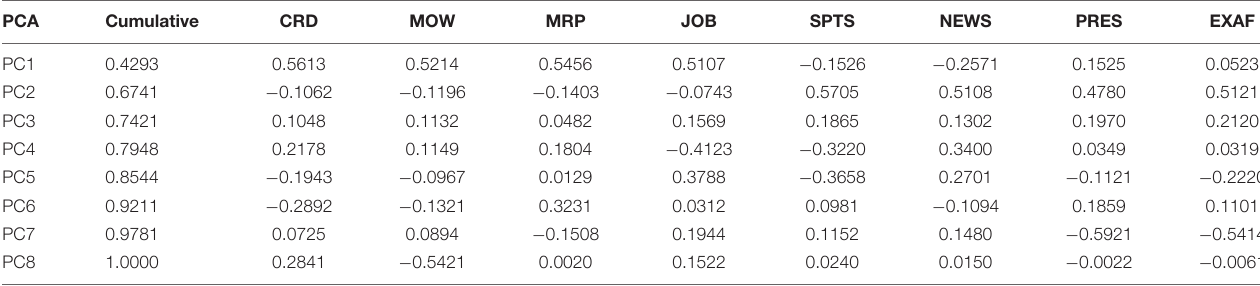
TABLE 1 | Principal component analysis (PCA) of QB